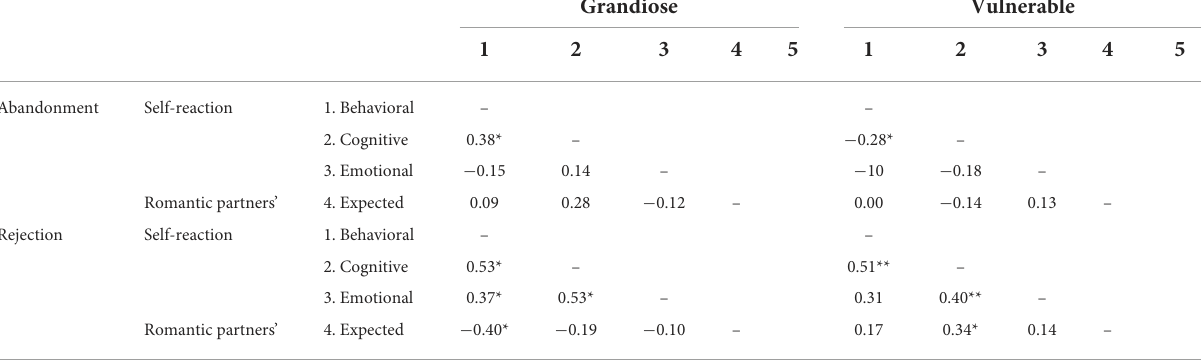
TABLE 2 Correlations between self and others’ reactions in return for grandiose and vulnerable